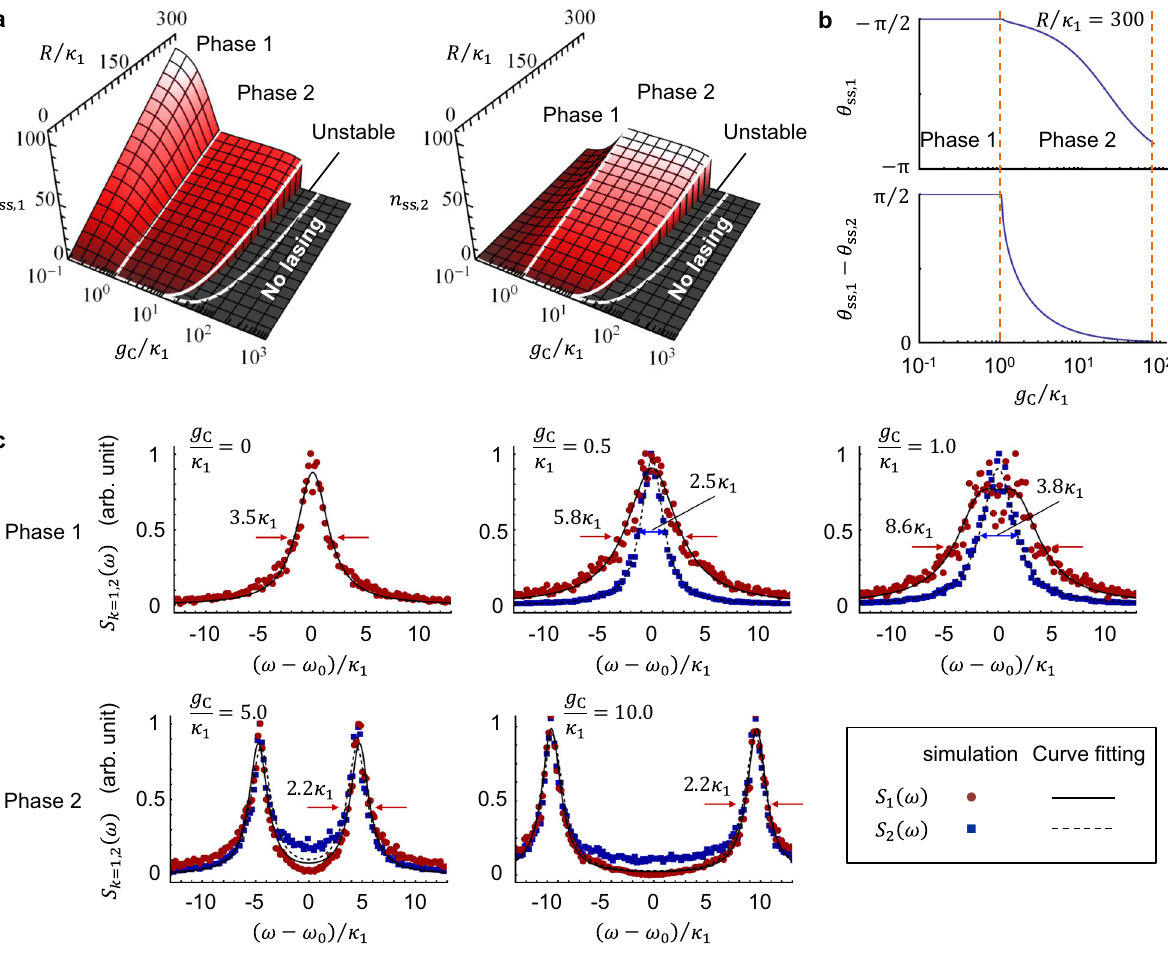
Fig. 2 Steady-state solutions of the conventional laser system. a Dependence of the intracavity photon numbers n ss ; k ¼ 1 ; 2 on the pumping rate R and the intercavity coupling strength g C . Here, the subscript ss represents the steady-state solutions and k ¼ 1 ; 2 denote the cavity 1 and 2, respectively. The photon loss rate κ of the cavity 1 is chosen as the frequency unit in the plot. Four distinct regimes are presented. In the phase 1, n 1 increases as g C is enhanced. In the phase 2, n ss ; k ¼ 1 ; 2 are nearly equal and slowly degrade when g C grows. In the unstable regime, both n k ¼ 1 ; 2 vary periodically in time. In the rest regime, both n ss ; k ¼ 1 ; 2 stay at zero, that is, no lasing action occurs. b Steady-state cavity- fi eld phases θ ss ; 1 and ð θ ss ; 1 (cid:2) θ ss ; 2 Þ as a function of g C . The pumping rate is fi xed at R = κ 1 ¼ 300. In the phase 1, both θ ss ; 1 and ð θ ss ; 1 (cid:2) θ ss ; 2 Þ maintain constant. In the phase 2, the phases vary with g C . c Emission spectra of two cavity fi elds S 1 ω ð Þ (red) and S 2 ω ð Þ (blue) at several selected values of g C . Here, ω denotes the angular frequency in the frequency domain via the Fourier transform and ω 0 corresponds to the central frequency of the laser transition. The pumping rate is set at R = κ 1 ¼ 300. The symbols are obtained from the numerical simulation, while the solid and dashed curves correspond to the curve fi tting. The full width at half-maximum of each spectral curve has been